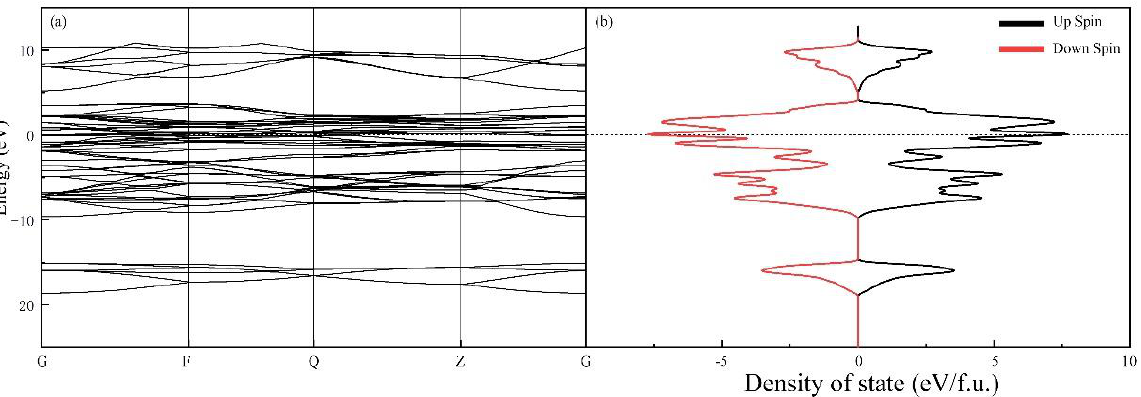
Figure 7. ( a ) Energy band diagram of the sample. ( b ) TDOS diagram of the sample. The Fermi surface has been marked with a dashed line.